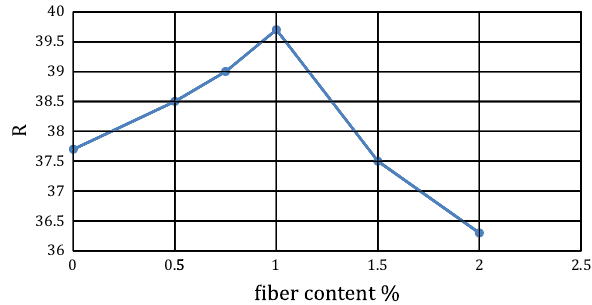
Figure 9: Rebound number and fi bers content relationship.